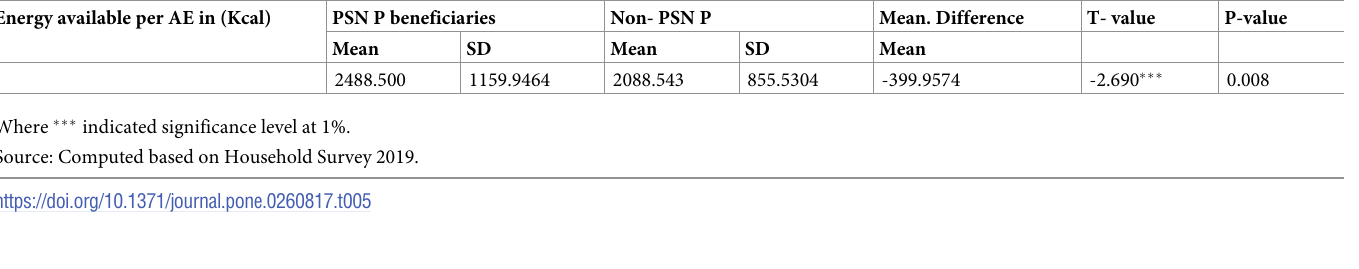
Table 5. Energy available per adult equivalent per day for sample households. Energy available per AE in (Kcal) PSN P beneficiaries Non- PSN P Mean. Difference T- value P-value Mean